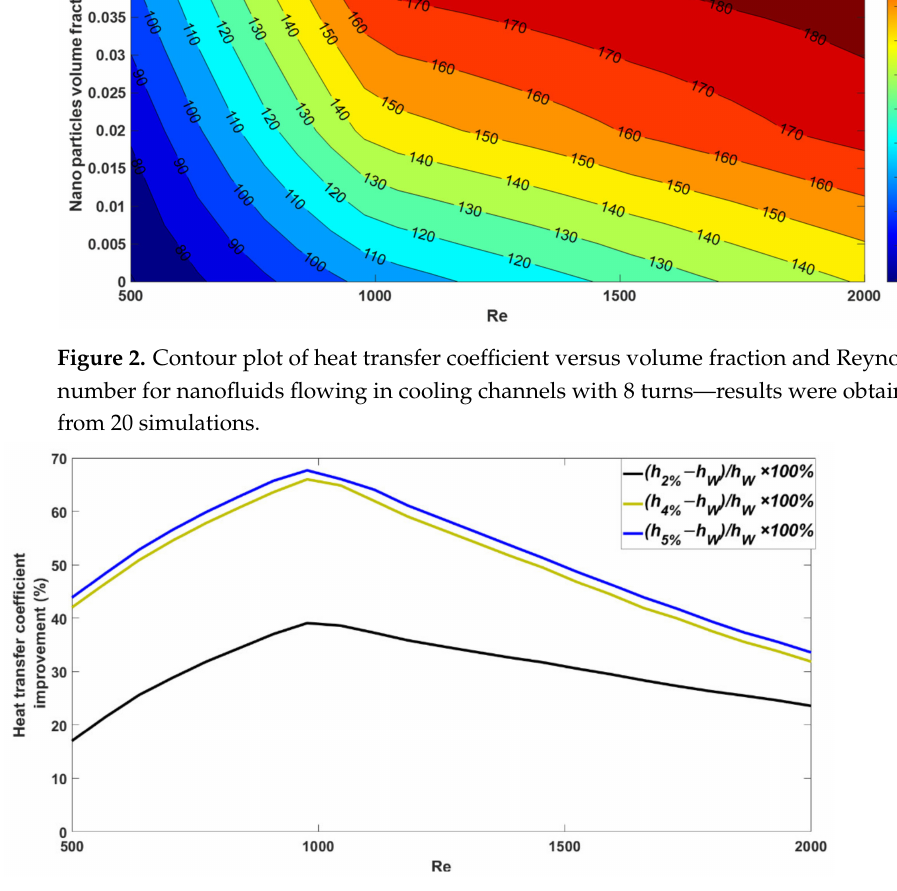
Figure 3. Relative heat transfer coefficient changes for nanofluids with 2%, 4%, and 5% volume fraction with respect to